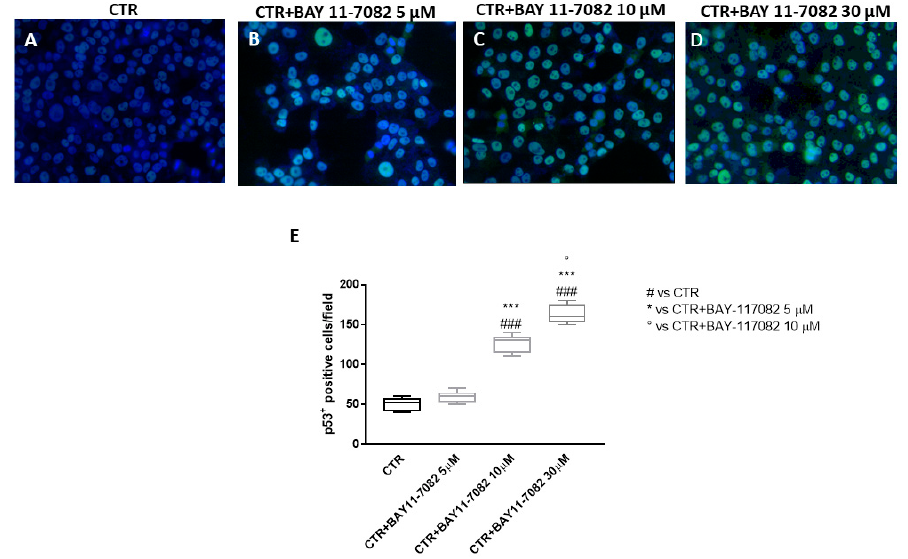
Figure 6. Effect of BAY-117082 on p53 expression. ( A – D ) Immunofluorescence assay revealed that BAY-117082 treatment at concentrations of 10 and 30 µM was able to significantly increase p53 expression compared to control group in CAL27 cells. Data are representative of at least three independent experiments. ( E ) ### p < 0.001 vs. CTR; *** p < 0.001 vs. CTR + BAY-117082 5 µM; ° p < 0.05 vs. CTR + BAY-117082 10 µM.